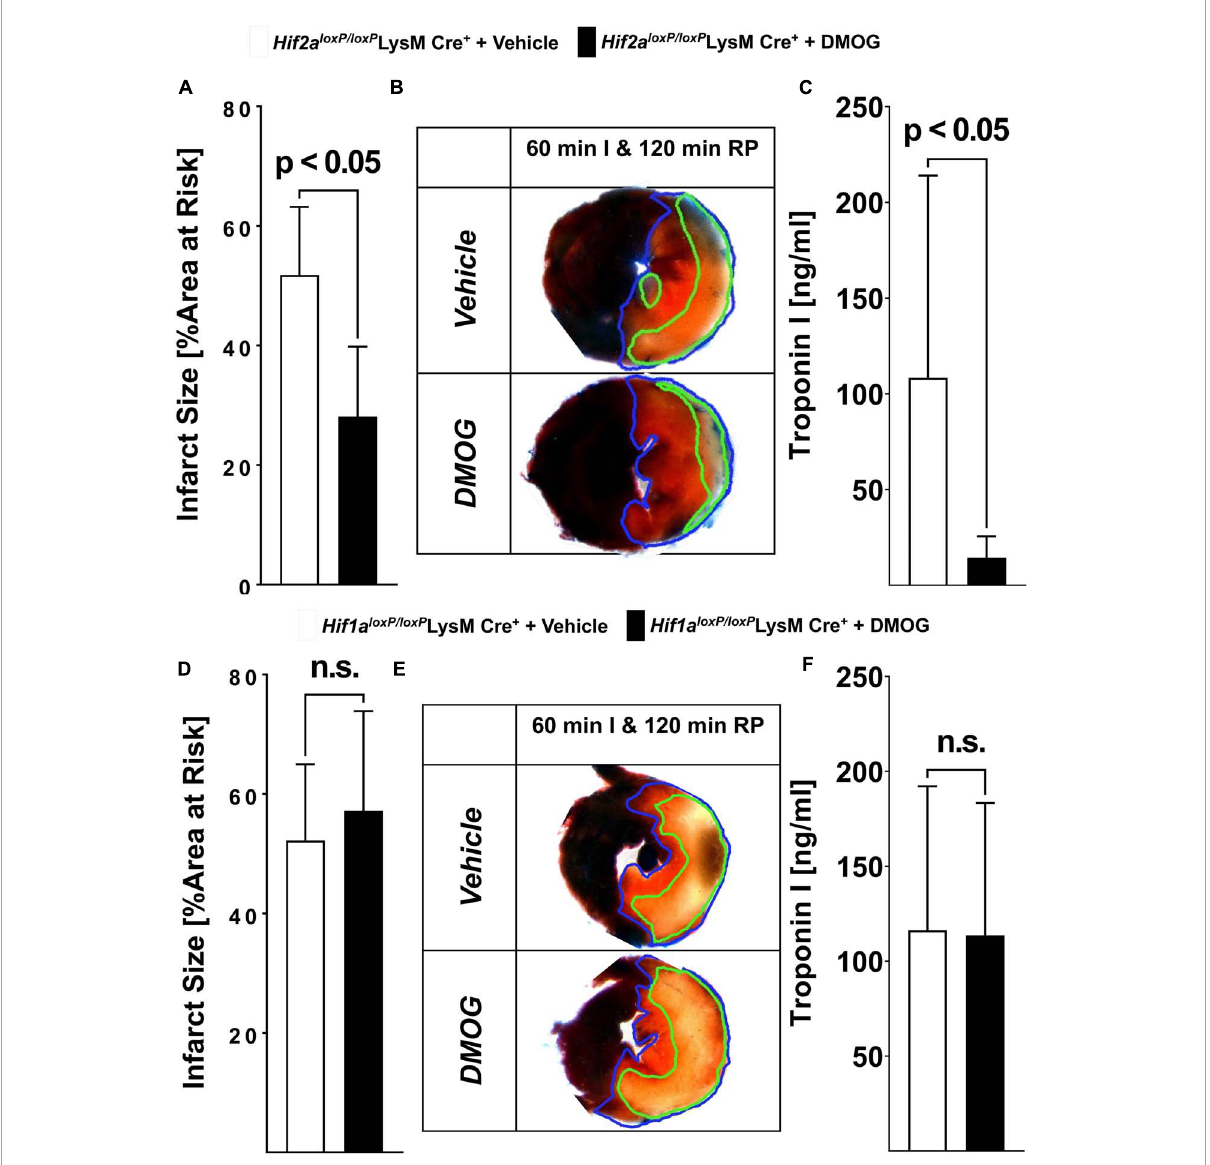
FIGURE5 Selective HIF-isoform deletion in PMN in myocardial ischemia and reperfusion. (A–F) Hif1a loxP / loxP or Hif2a loxP / loxP were crossed with Cre recombinase expressing mice under the control of the lysozyme 2 promoter (LysM Cre+) to generate animals deficient in myeloids-specific Hif1a or Hif2a. Mice received vehicle or 1 mg of HIF stabilizing DMOG 4 h before ischemia. Mice underwent 60 min of ischemia and 120 min of reperfusion and evaluation of myocardial injury infarct sizes measurement and serum troponin I concentrations. (A) Infarct sizes were determined in vehicle or DMOG treated Hif2a loxP / loxP LysM Cre+ mice ( n = 5 per group). (B) Representative infarct staining from vehicle or DMOG treated Hif2a loxP / loxP LysM Cre+ mice. (C) Serum levels of troponin in vehicle or DMOG treated Hif2a loxP / loxP LysM Cre+ mice ( n = 5